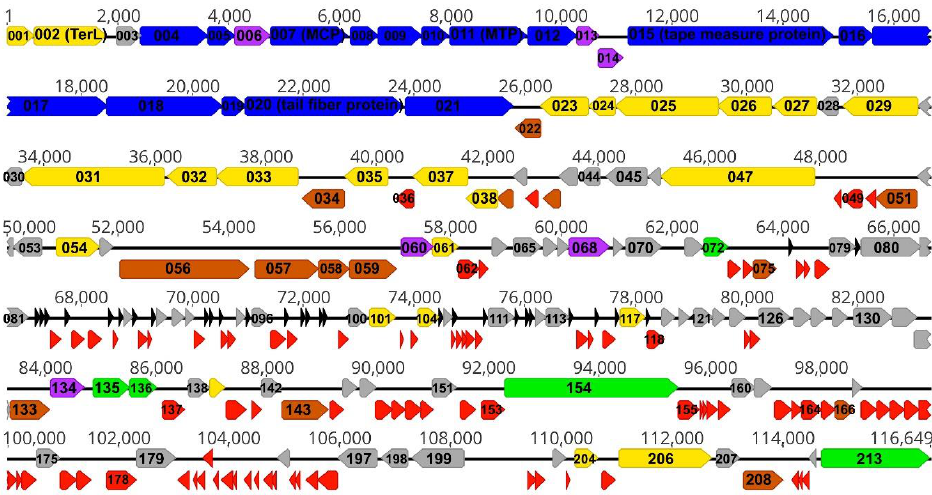
Figure 2. Functional genome map of bacteriophage AAS21. The coding capacity of the AAS21 genome is shown. The numbers indicate gene position in the genome, gene functions are assigned according to the characterized open reading frames (ORFs) in the NCBI database and HHpred analysis. The color code is as follows: yellow—DNA replication, recombination, repair, and packaging; brown—transcription, translation, and nucleotide metabolism; blue—structural proteins; purple—virion morphogenesis-related proteins; green—lysis, phage-host interaction; grey—ORFs of unknown function; red—AAS21 specific ORFs that encode unique proteins with no reliable identity to database entries,